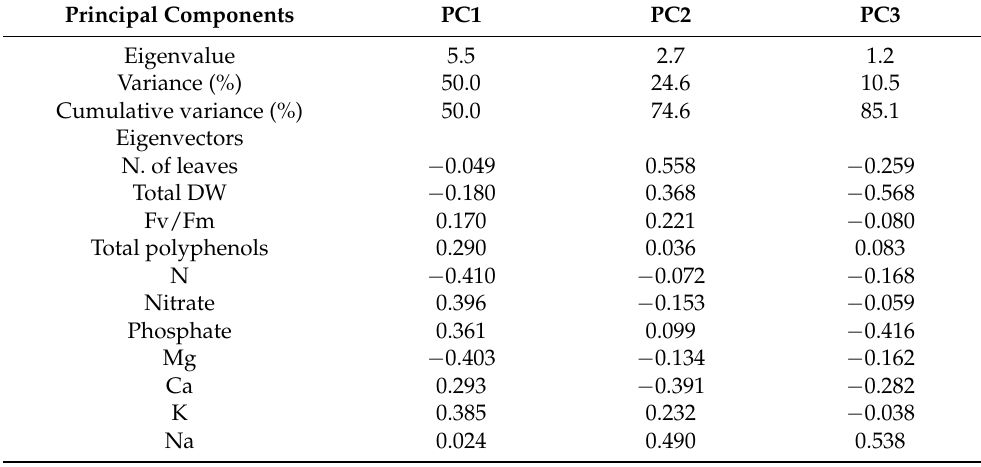
Figure 8. Data scores ( A ) and variable loadings with the contribution of variables ( B ) obtained by PCA. Table 4. Eigenvalues, factor patterns, and percentages of the variance explained by each